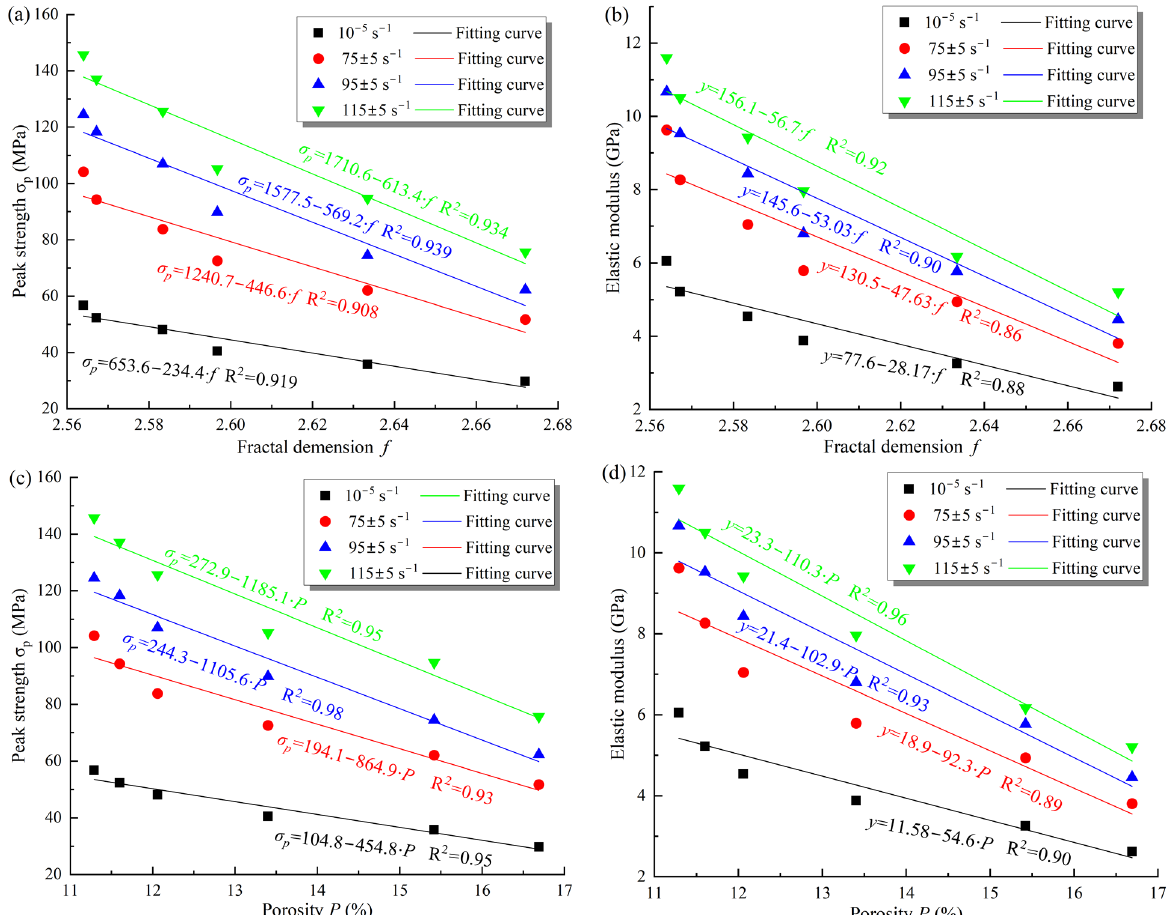
Figure 15. Connection between mechanical properties and microscopic parameters of samples. ( a ) Peak strength vs. fractal dimension; ( b ) elastic modulus vs. fractal dimension; ( c ) peak strength vs. porosity; ( d ) elastic modulus vs. porosity.